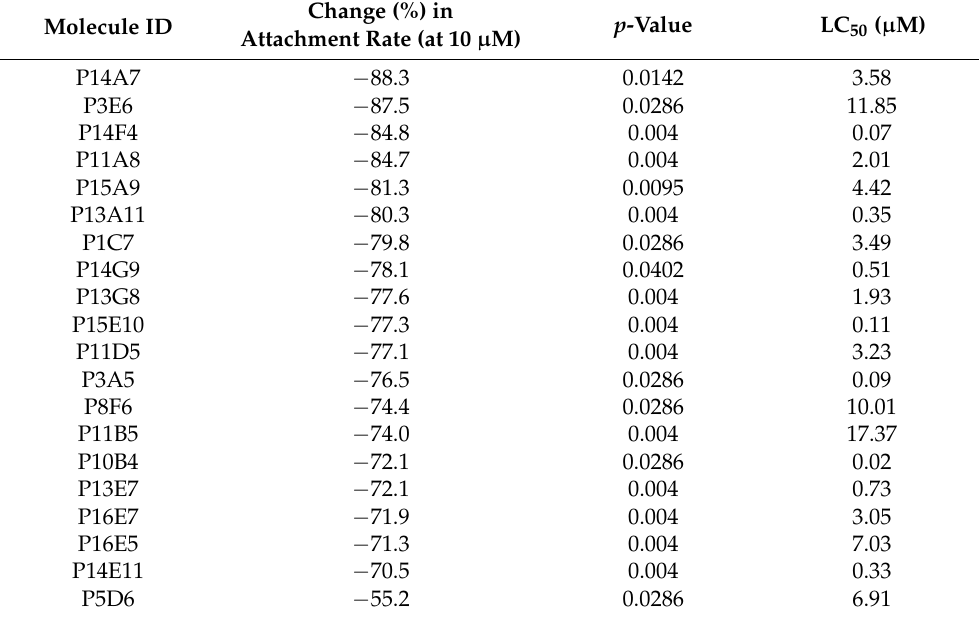
Table 1. The top 20 LOPAC (compound ID) with the highest changes in attachment rate. Change (%) in p Molecule ID